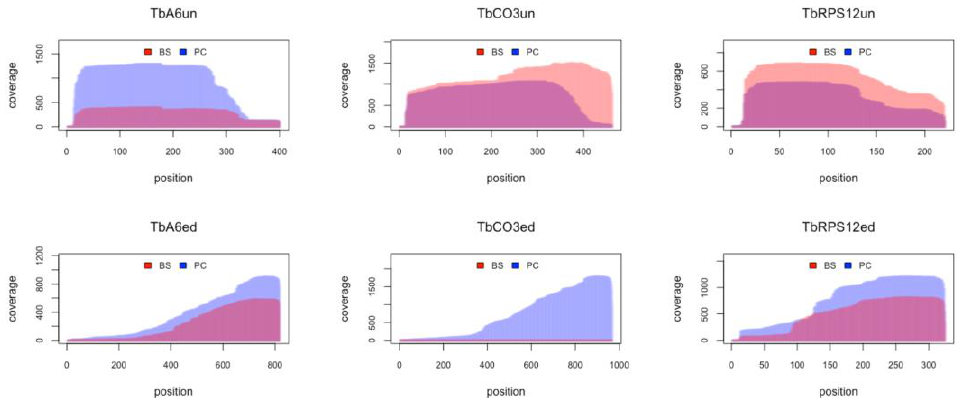
Figure 9. DRS captures the efficiency of mitochondrial RNA editing. Overlay profiles from bloodstream-stage (BS, red) and procyclic-stage (PC, blue) T. brucei (Tb) comparing the sequence coverage of unedited (un, top panel) and edited (ed, bottom panel) transcripts of the mitochondrial ATPase subunit 6 (A6), cytochrome oxidase 3 (CO3), and ribosomal protein S12 (RPS12).